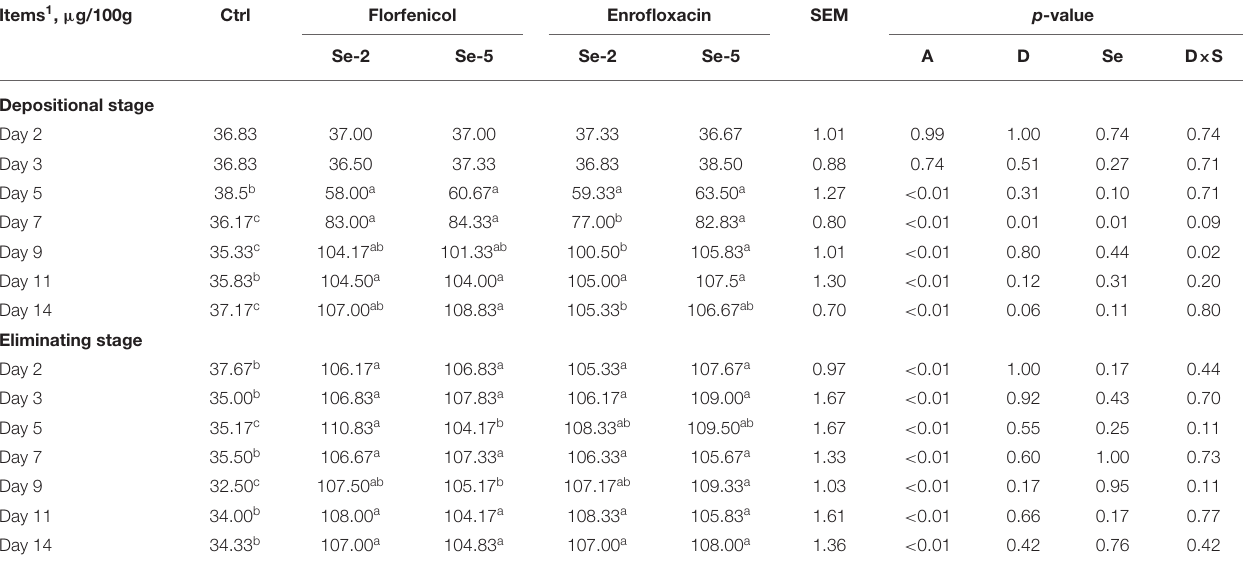
TABLE 9 | Effects of dietary organic selenium and drugs on the concentration of selenium in egg yolk of laying hens. Items 1 , µ g/100g Ctrl Florfenicol Enrofloxacin SEM p -value Se-2 Se-5 Se-2 Se-5 Se D ×